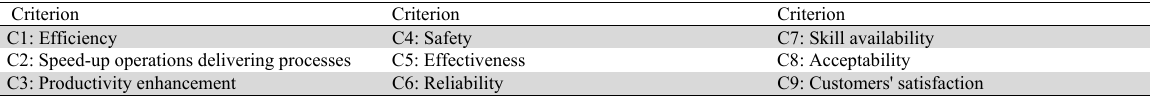
Evaluation criteria Criterion